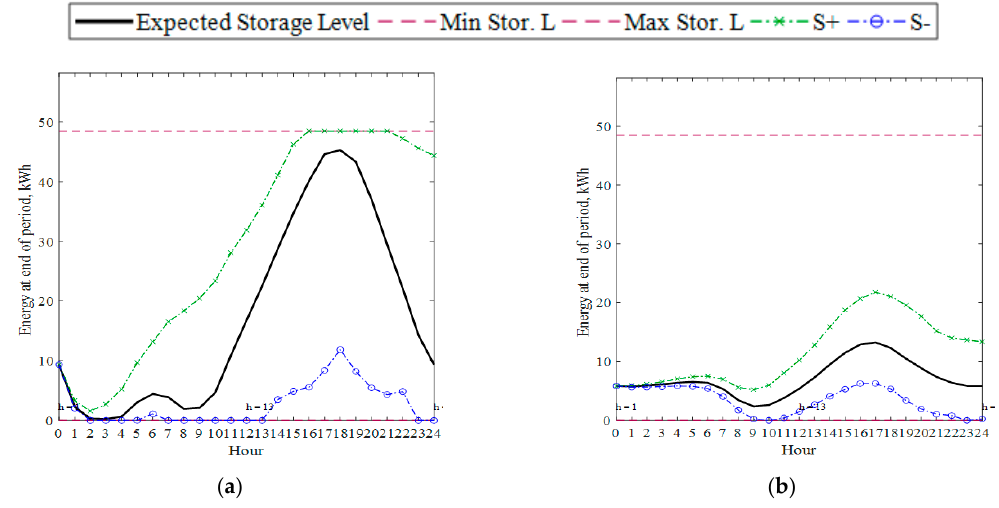
Figure 14. Average cycling pattern of an EV battery for 10% and 100% participation rates in 2030: ( a ) 10% participation; ( b ) 100% participation.